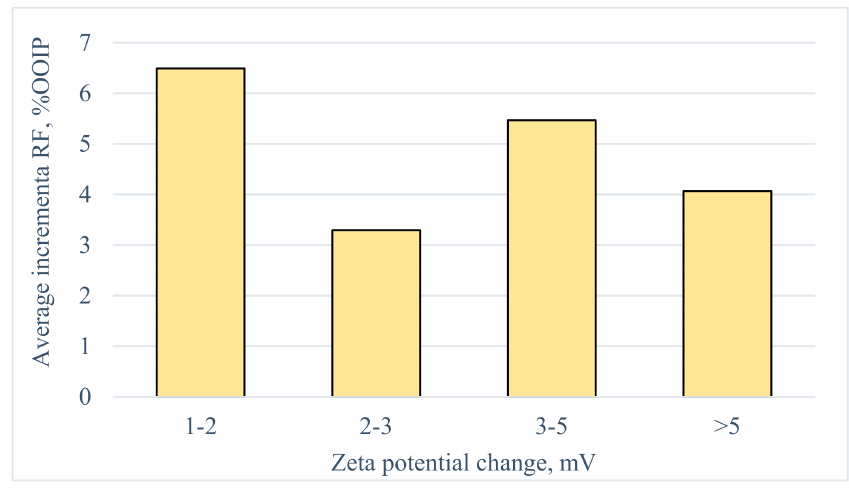
Figure 10. Average incremental RF vs. zeta potential change.